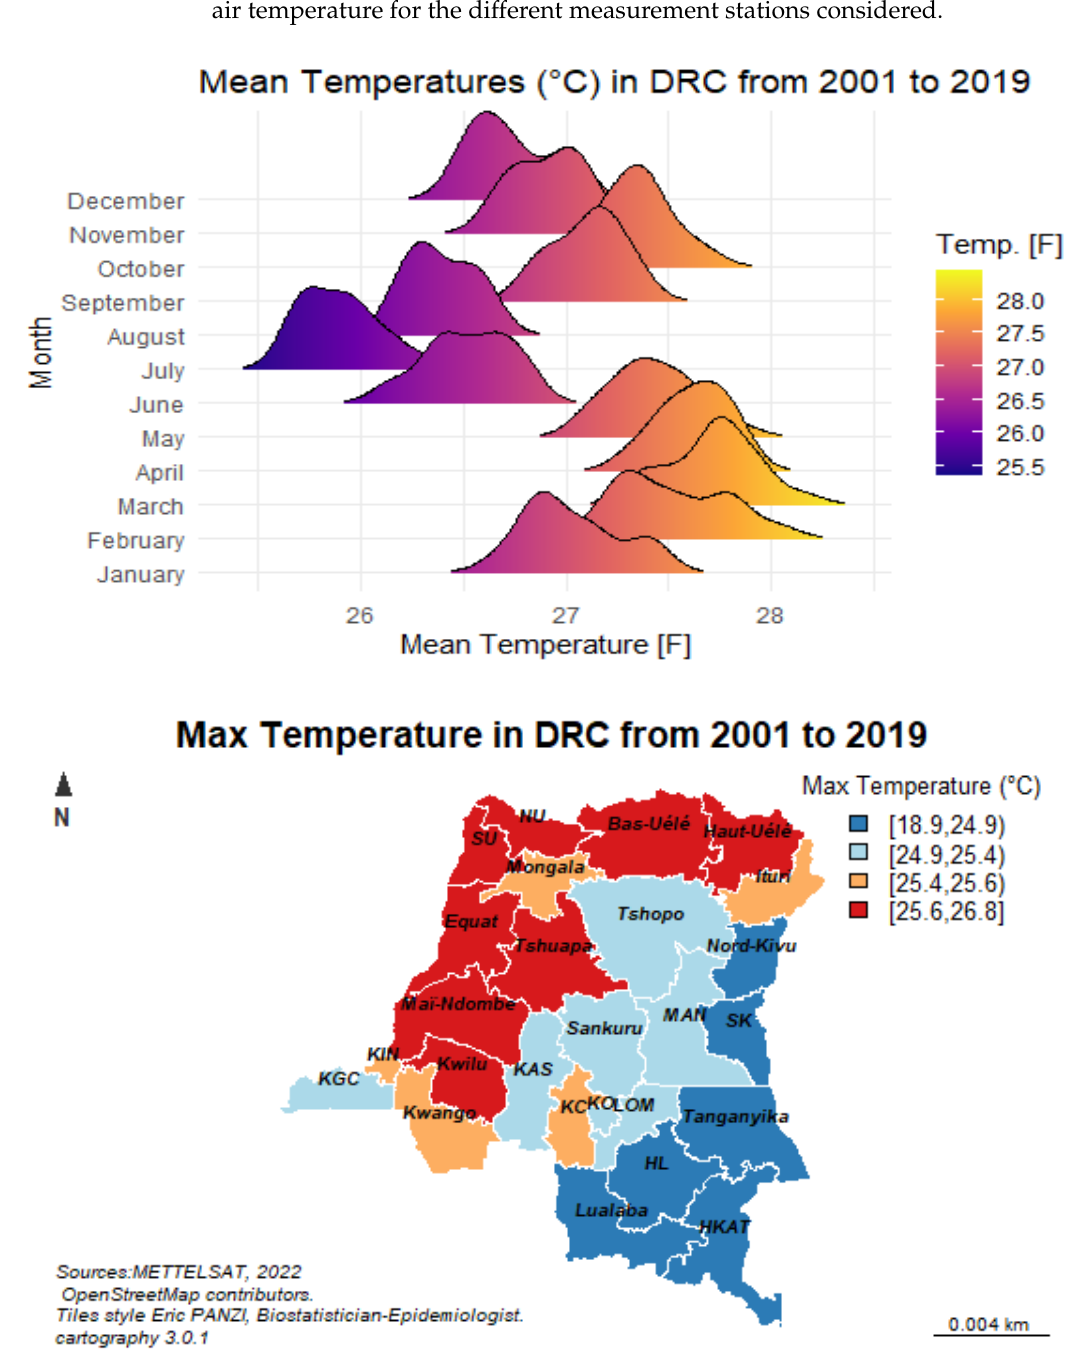
Figure 6. Evolution of average temperatures from 2001 to 2019 (for the legend of the provinces, see the Appendices A and B).